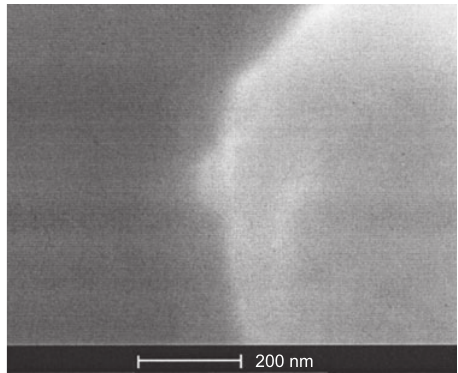
Figure 18 Gold nanoparticles embedded in a carbon matrix at the apex of a fi ber tip by direct EBID. Reprinted with permission from [113] . Copyright 2002, American Institute of